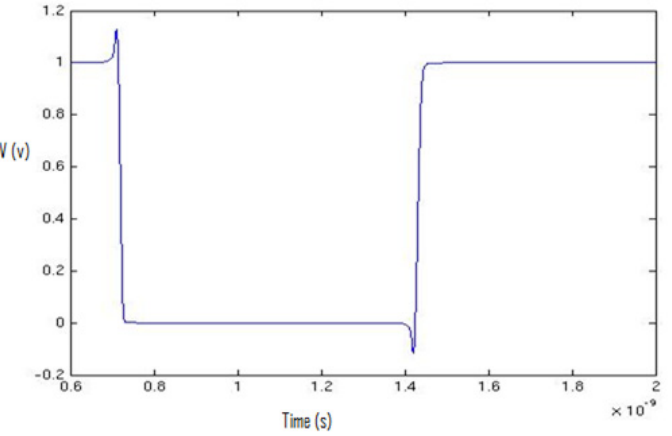
Figure 2. Inverter output plot (one cycle) in MATLAB.